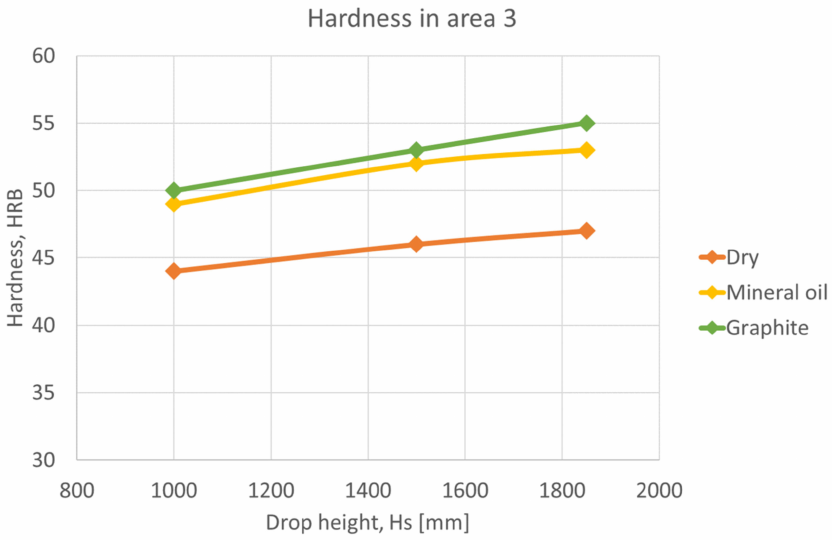
Figure 17. Variation of hardness as a function of ram drop height, in area